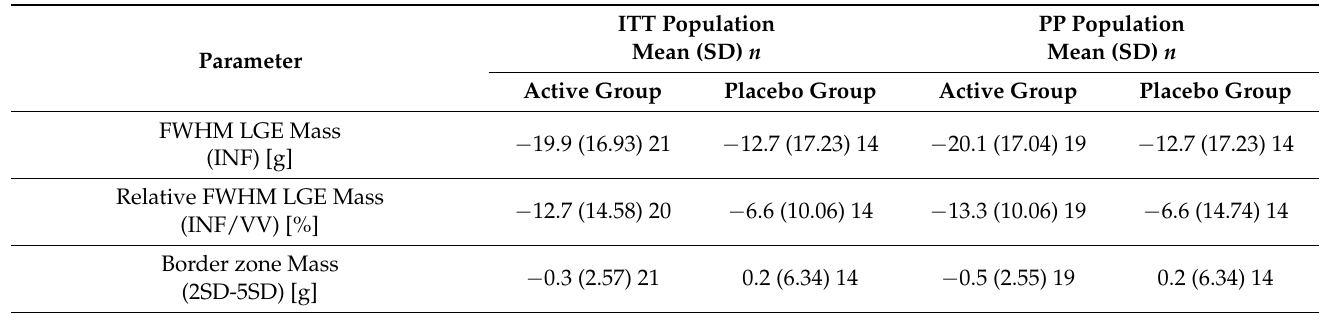
Table 5. Summary of Tissue Characterization Parameters from Day 3 to Day 90 (ITT and PP